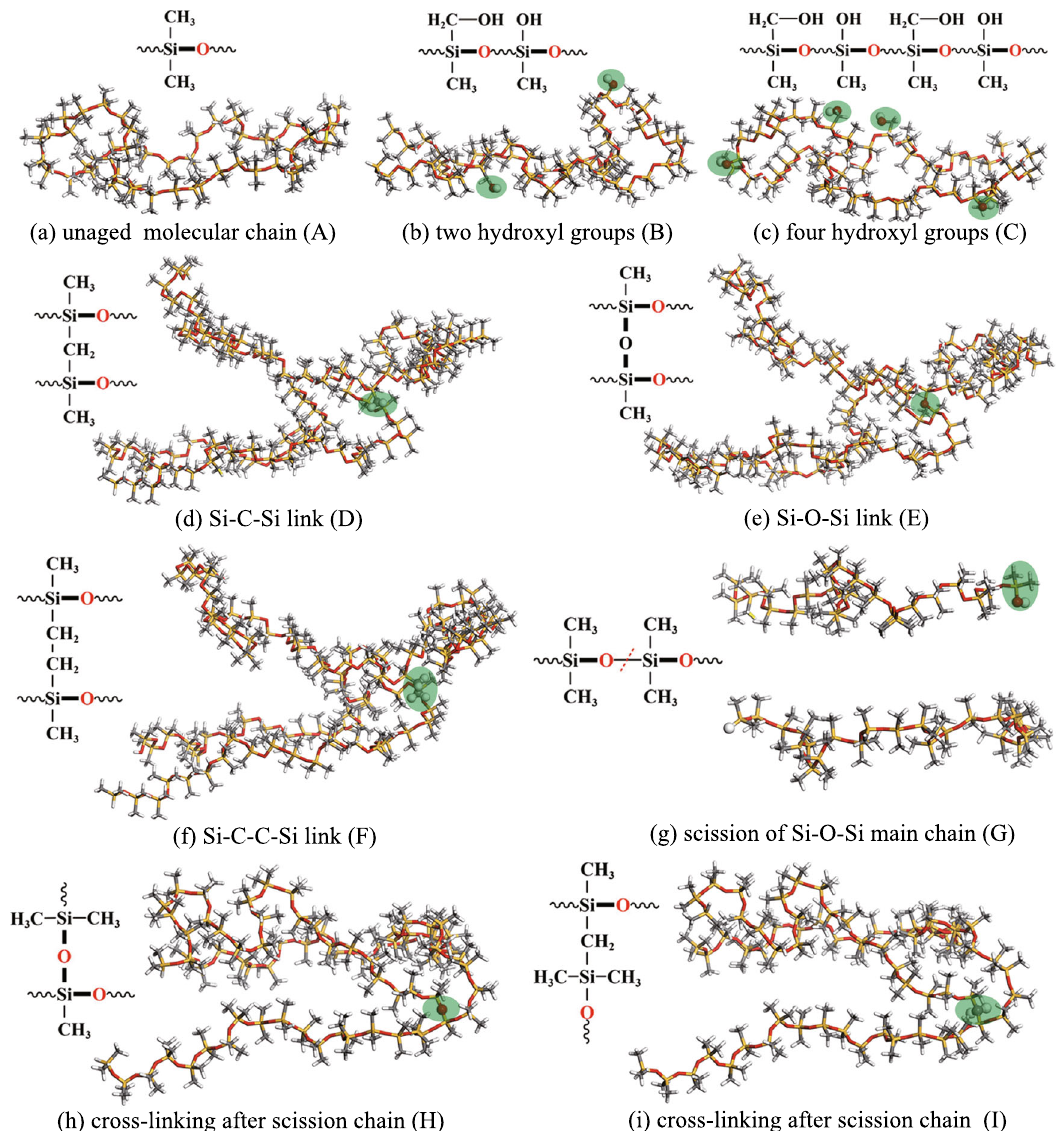
Fig. 15 The typical chemical structures of the unaged and aged PDMS chains. a unaged chain A, b oxidized chain B with two hydroxyl groups, c oxidized chain C with four hydroxyl groups, d cross-linking structure of Si-C-Si link d , e cross-linking structure of Si-O-Si link e , f cross- linking structure of Si-C-C-Si link f , g scission structure G of Si – O-Si main chain, h cross-linking structure f after scission chain, and i cross- linking structure i after scission chain.